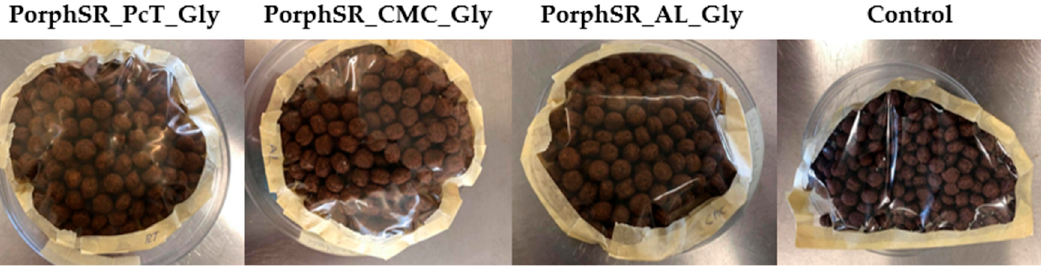
Figure 3. Cereals with chocolate packaged in packaging produced from PorphSR_PcT_Gly, PorphSR_CMC_Gly and PorphSR_CMC_Gly and Polyethylene (Control) films.